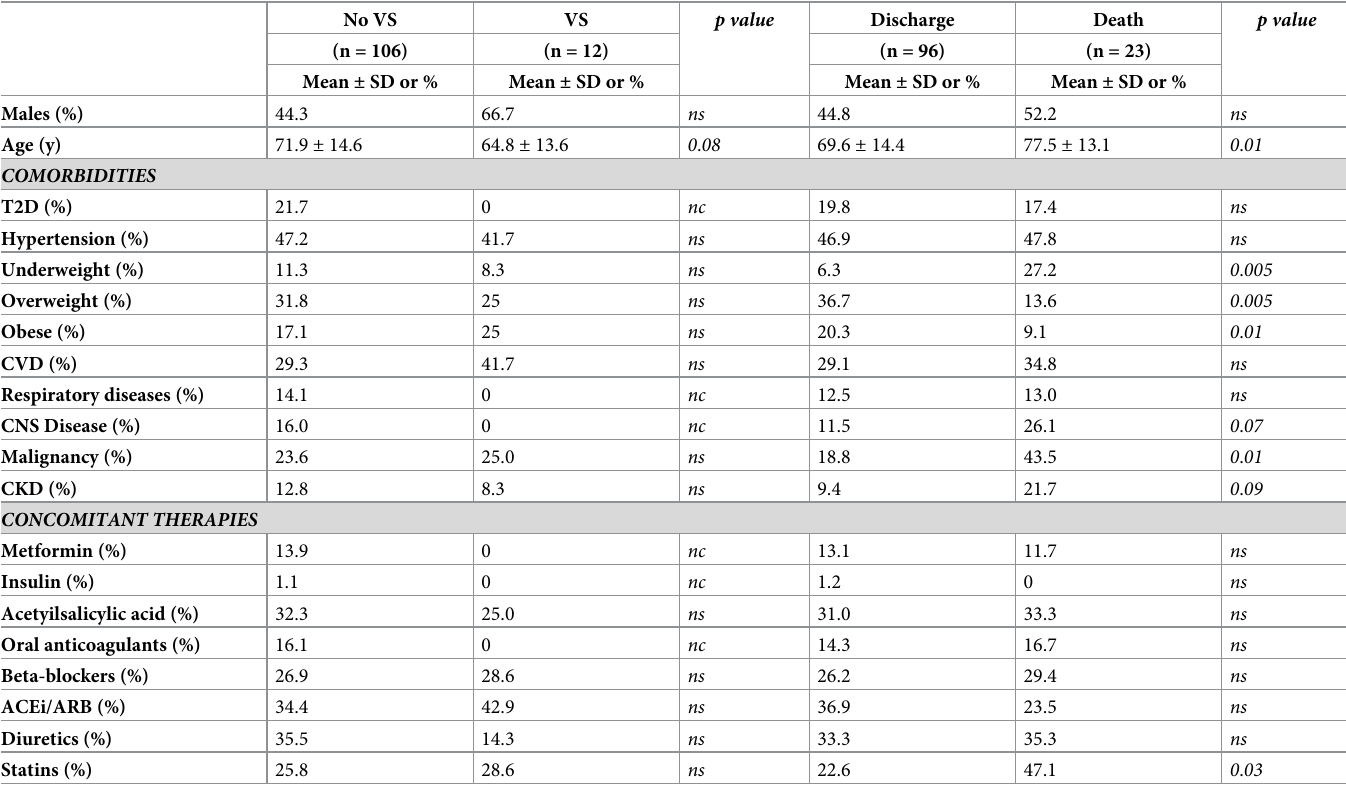
Table 1. Baseline characteristics of COVID-19 patients who presented unfavorable outcomes (ventilation support need and death) and those who did not. No